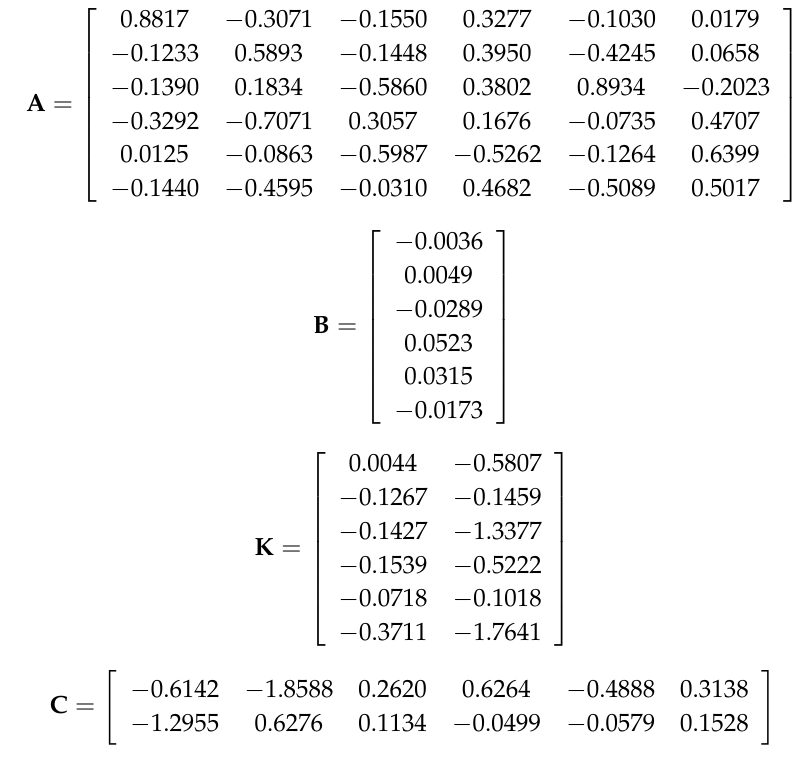
Figure 8 is corresponding to the value of 0.0006522.